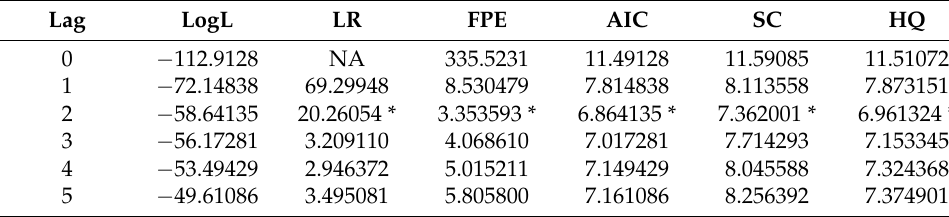
Table 3. VAR lag selection criteria.